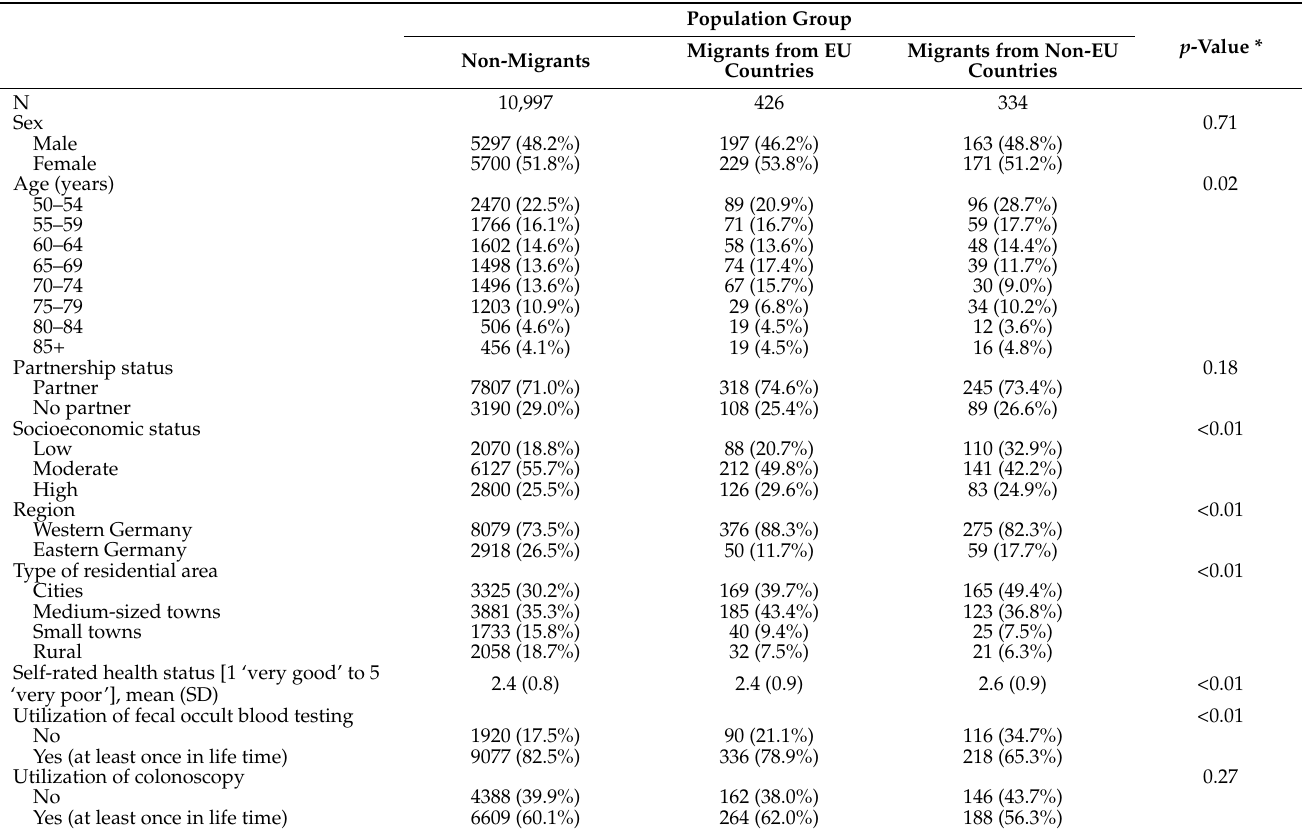
Table 1. Description of the study sample by population group (German Health Update 2014/2015, respondents aged ≥ 50 years, n = 11,757).